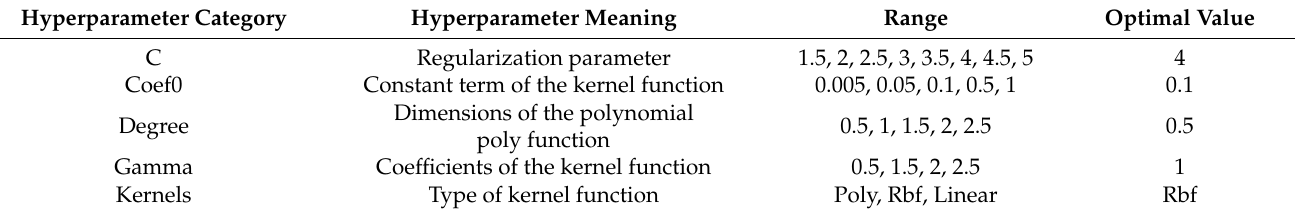
Table 4. Optimized hyperparameter types, meanings, ranges and optimal values of SVM.